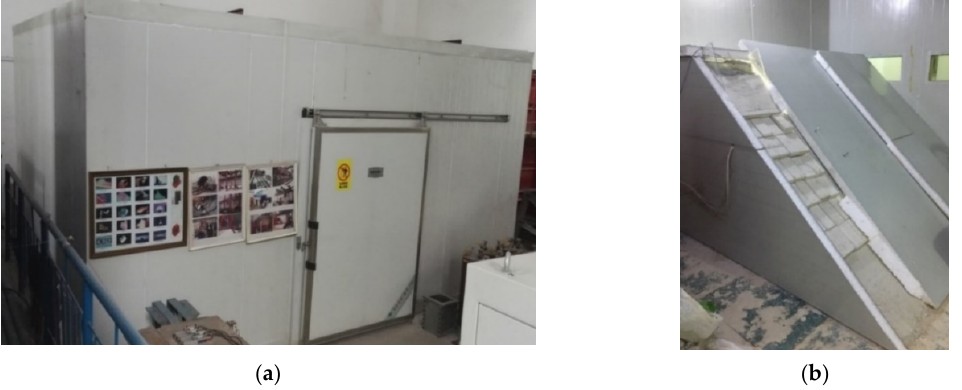
Figure 3. The refrigeration and insulation equipment. ( a ) Large-scale test cold storage unit. ( b ) In- cubator in the cold storage unit.